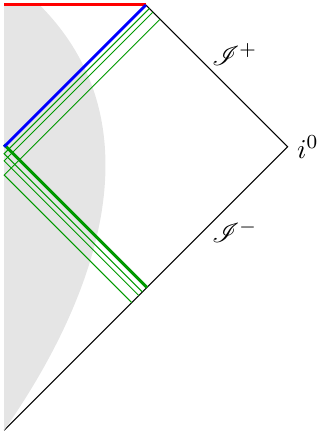
Figure 2 . Penrose diagram of a gravitational collapse and subsequent formation of a black hole, whose event horizon is depicted in blue. The grey area represents the interior of the collapsing matter, while the red line corresponds to the black-hole singularity. The green lines are null hyper- surfaces, with the thick green line corresponding to v = v 0